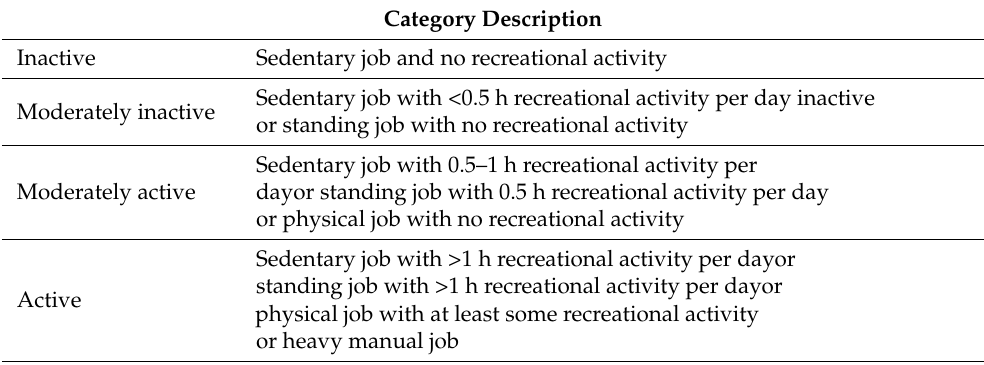
Table A2. Description of Physical Activity Categories.